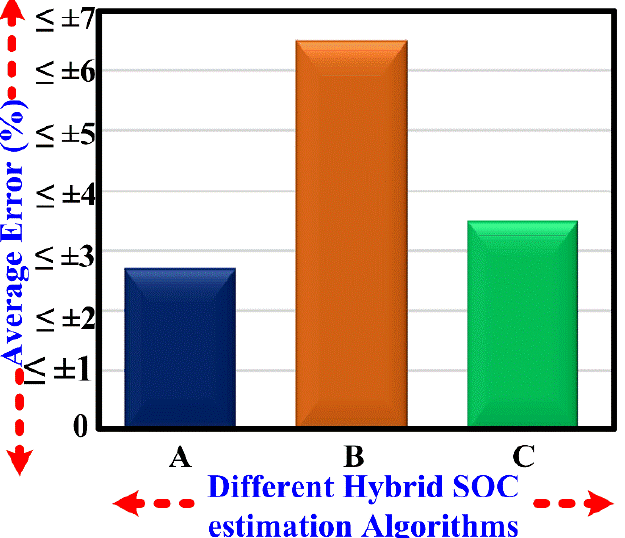
Figure 14. Comparison between the different deep learning SOC estimation algorithms. “A” is referred to as [117], “B” is referred to as [119], and “C” is referred to as [120].